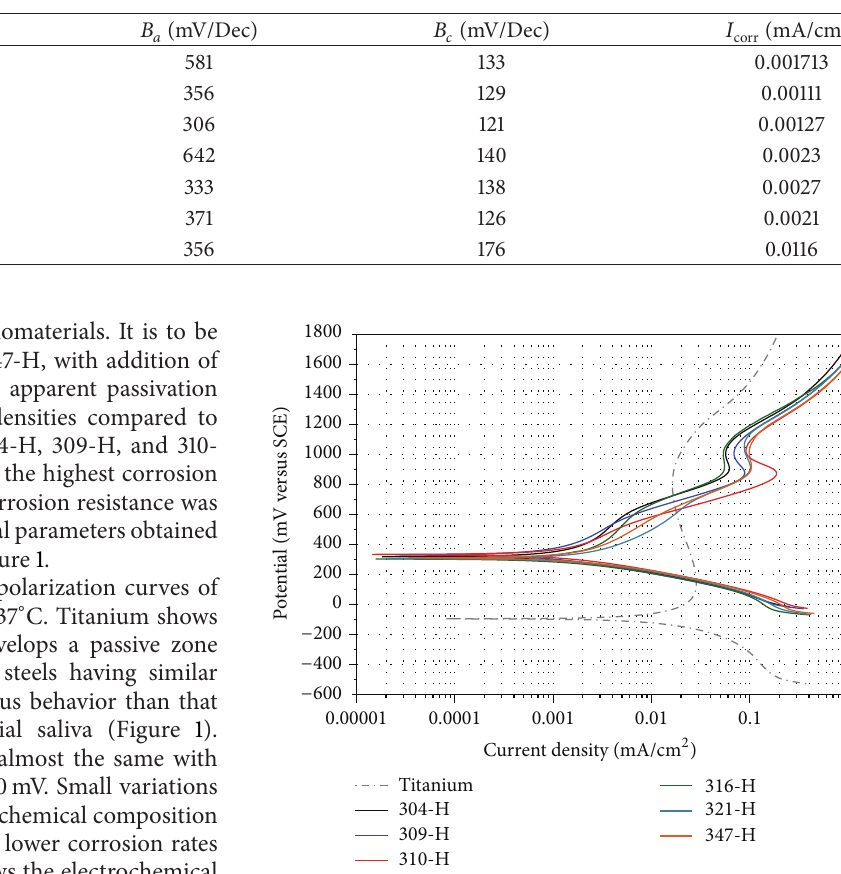
Table 4: Electrochemical parameters of the materials evaluated in mouthwash at 37 ∘ C.